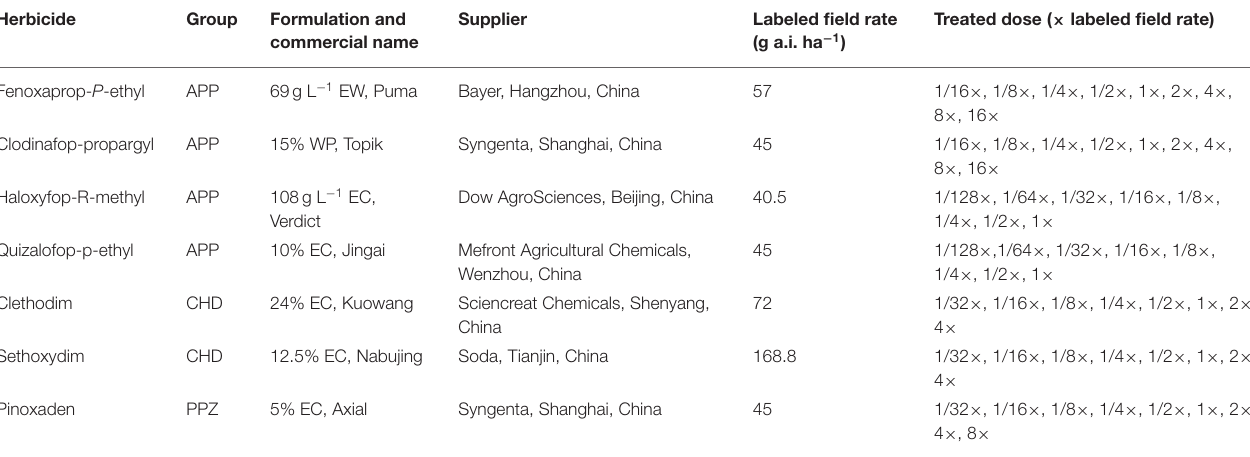
TABLE 2 | Detailed information of herbicides, labeled field rates, and treated doses in the whole-plant dose–response studies. Herbicide Group Formulation and Supplier Labeled field rate Treated dose ( × labeled field commercial name (g a.i. ha − 1 )